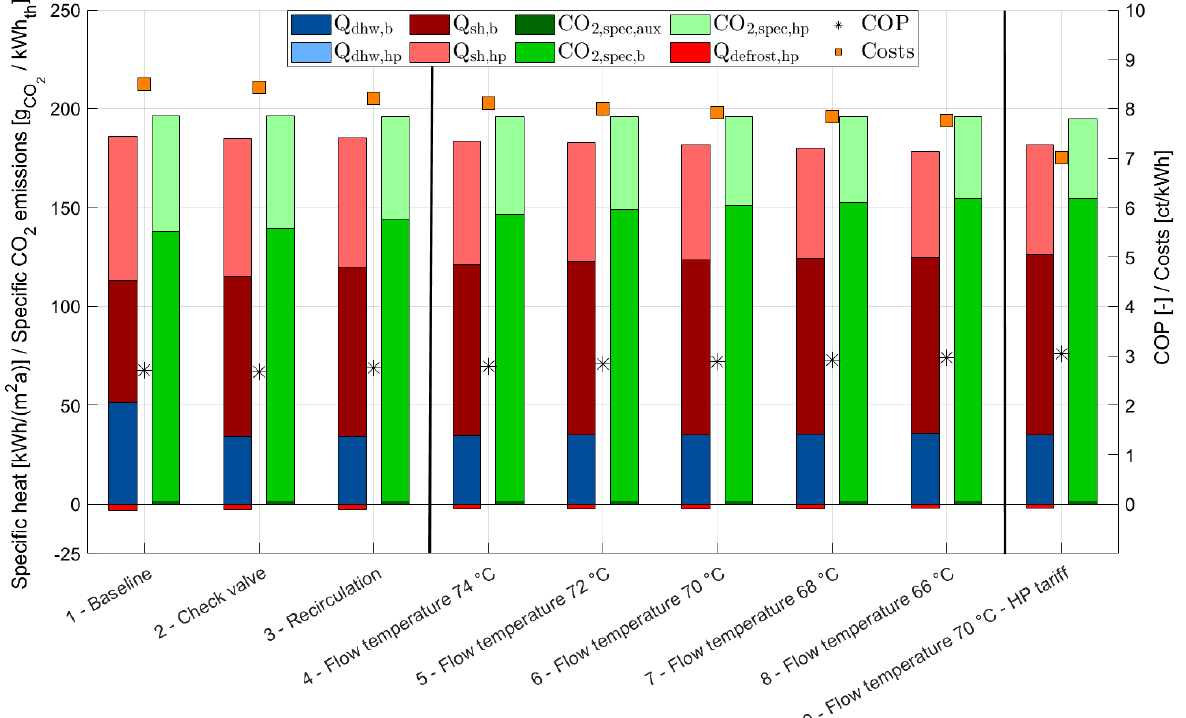
Figure 22. Comparison of the provided heat and specific CO 2 emissions and costs with different improvement measures.